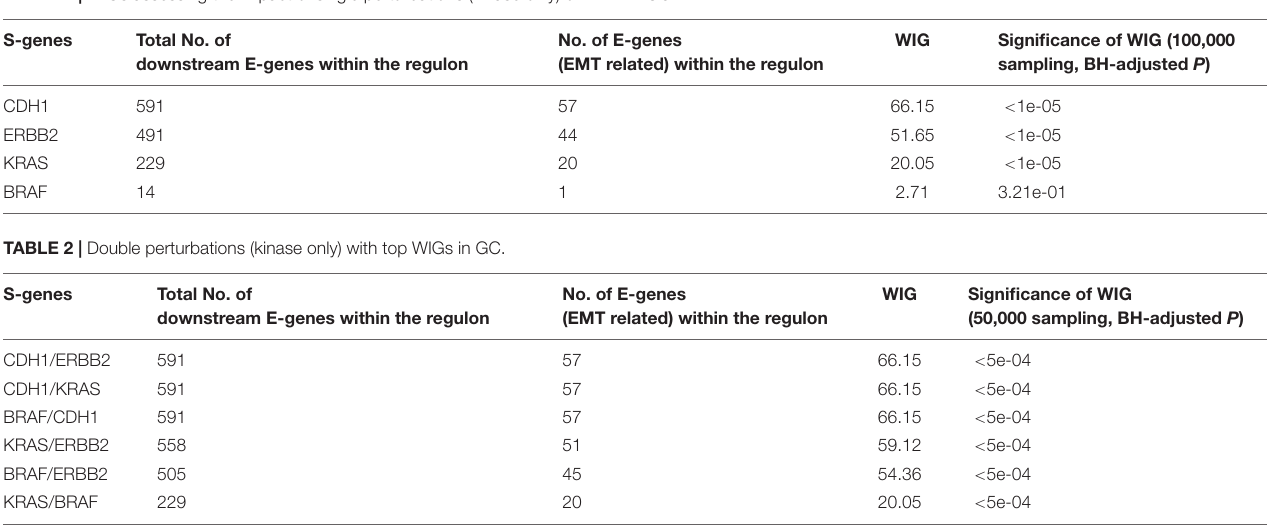
TABLE 1 | WIGs assessing the impact of single perturbations (kinase only) on EMT in GC. S-genes Total No. of downstream E-genes within the regulon